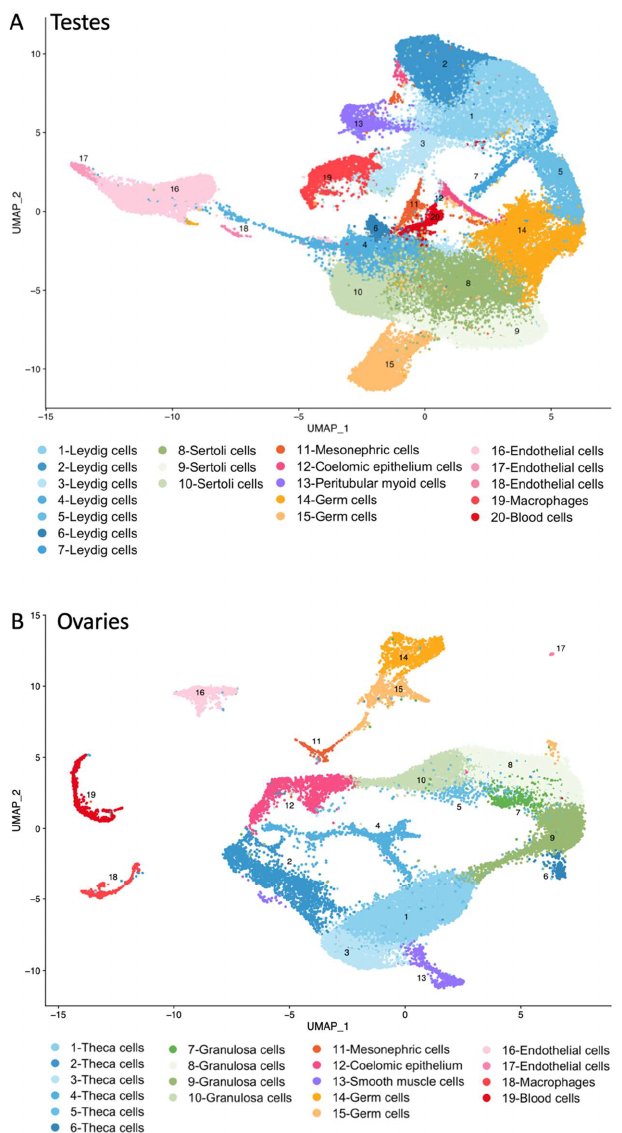
Figure 2. UMAP plots of cell clusters in human ( A ) testes from embryonic stage to adults; and ( B ) ovaries from embryonic and foetal stages identified by single cell RNA sequencing. UMAP: uniform manifold approximation and projection.